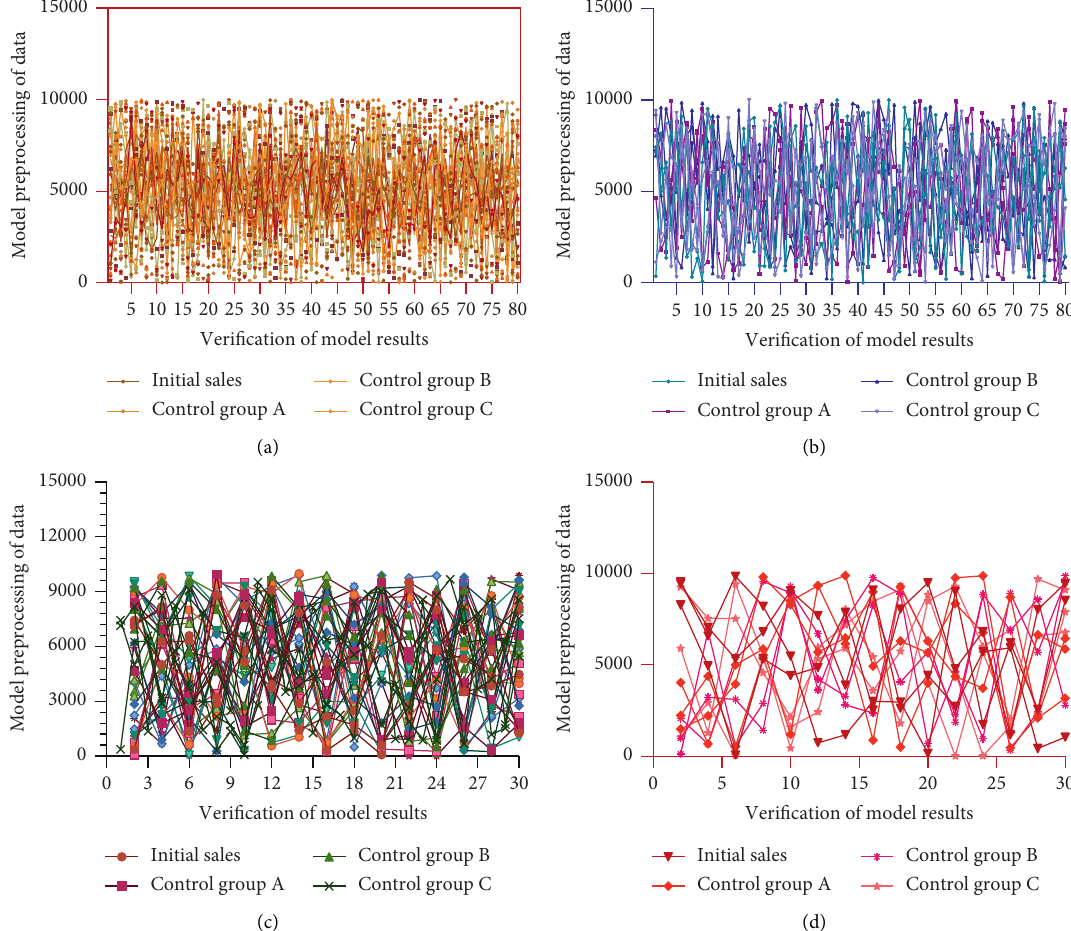
Figure 9: Market evaluation form segmented by psychological factors. (a) ACB original sales value. (b) ACB control group A sales value. (c) ACB control group B sales value. (d) ACB control group C sales value.